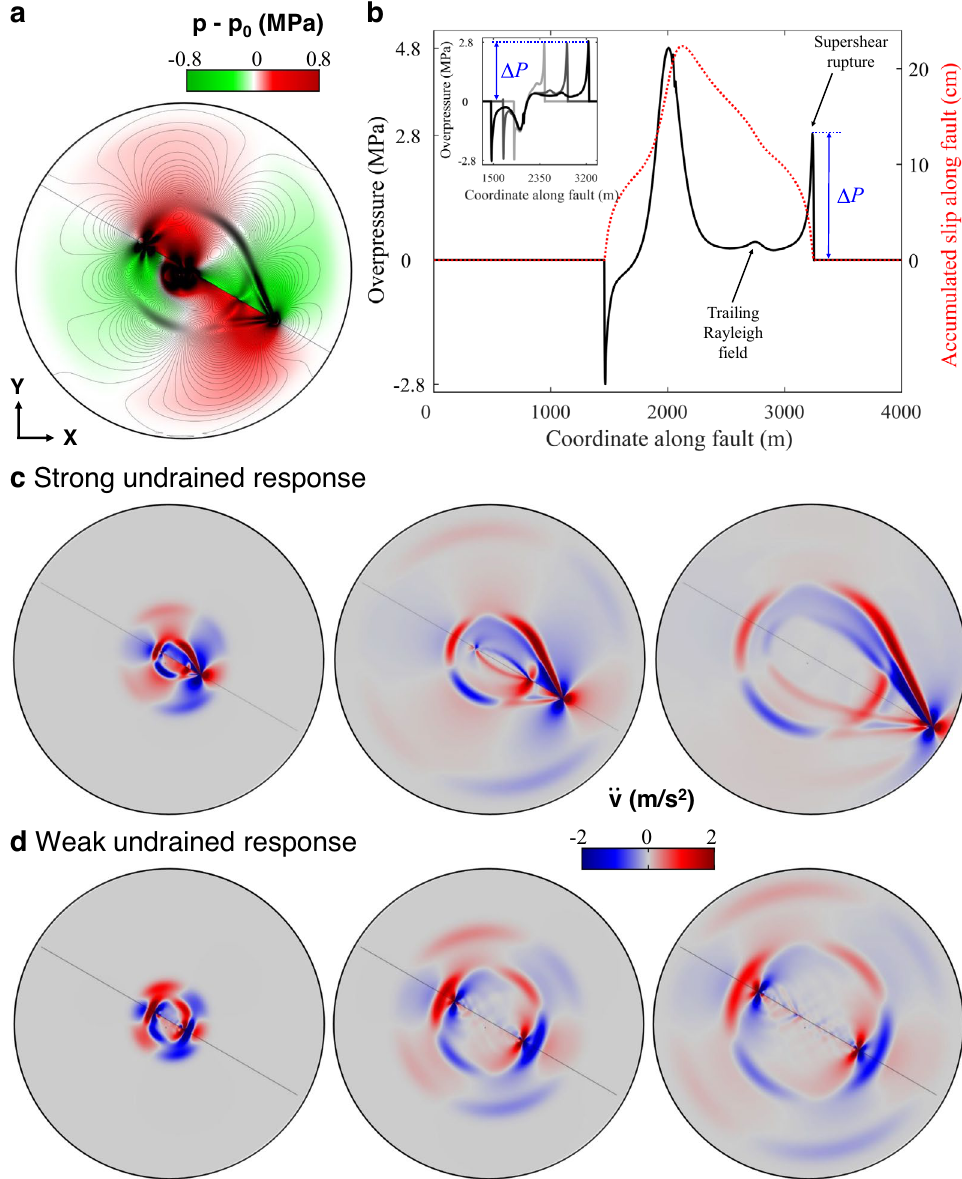
Figure 2. Undrained poroelastic response as a coseismic weakening mechanism. With the simulation setup of Fig. 1, we illustrate the influence of pore pressure response on rupture propagation speed. ( a ) Snapshot of coseismic pore pressure changes and contours of shear stress during rupture propagation. The reference pressure state, p 0 , is computed right before nucleation. Fast fault slip propagation leads to a pattern of compressions and extensions that induce sudden changes in pore pressure around the fault (red, increases; green, decreases). ( b ) Undrained pressure changes are particularly strong and sharp at the rupture tip, as revealed by the profiles of pore overpressure (solid black line) and accumulated slip (dotted red line) along one side of the fault. The undrained overpressure at the detachment front, (cid:31) P , remains nearly constant over time (inset of b ). ( c , d ) To highlight the impact of undrained response on earthquake rupture speed, we show the effect of changing Biot’s coefficient on the type of rupture propagation, while keeping the other parameters constant. In the case of α B 0 ( d ), which neglects poroelastic coupling, rupture is symmetric and sub-Rayleigh, whereas for α B ensuing rupture is asymmetric, with one of the edges propagating at supershear